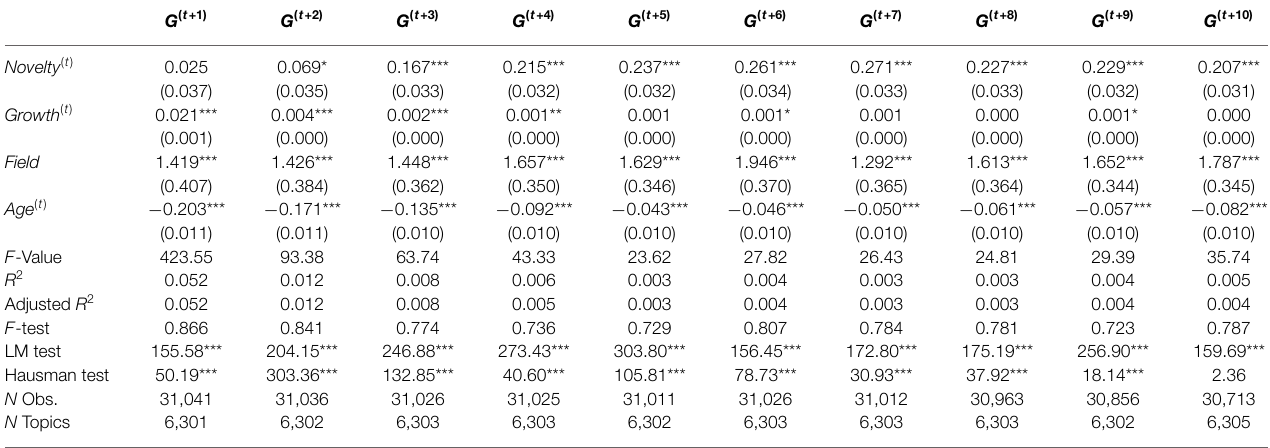
TABLE 4 | Growth ( t + ∆ t ) random-effect models (1991–1995).